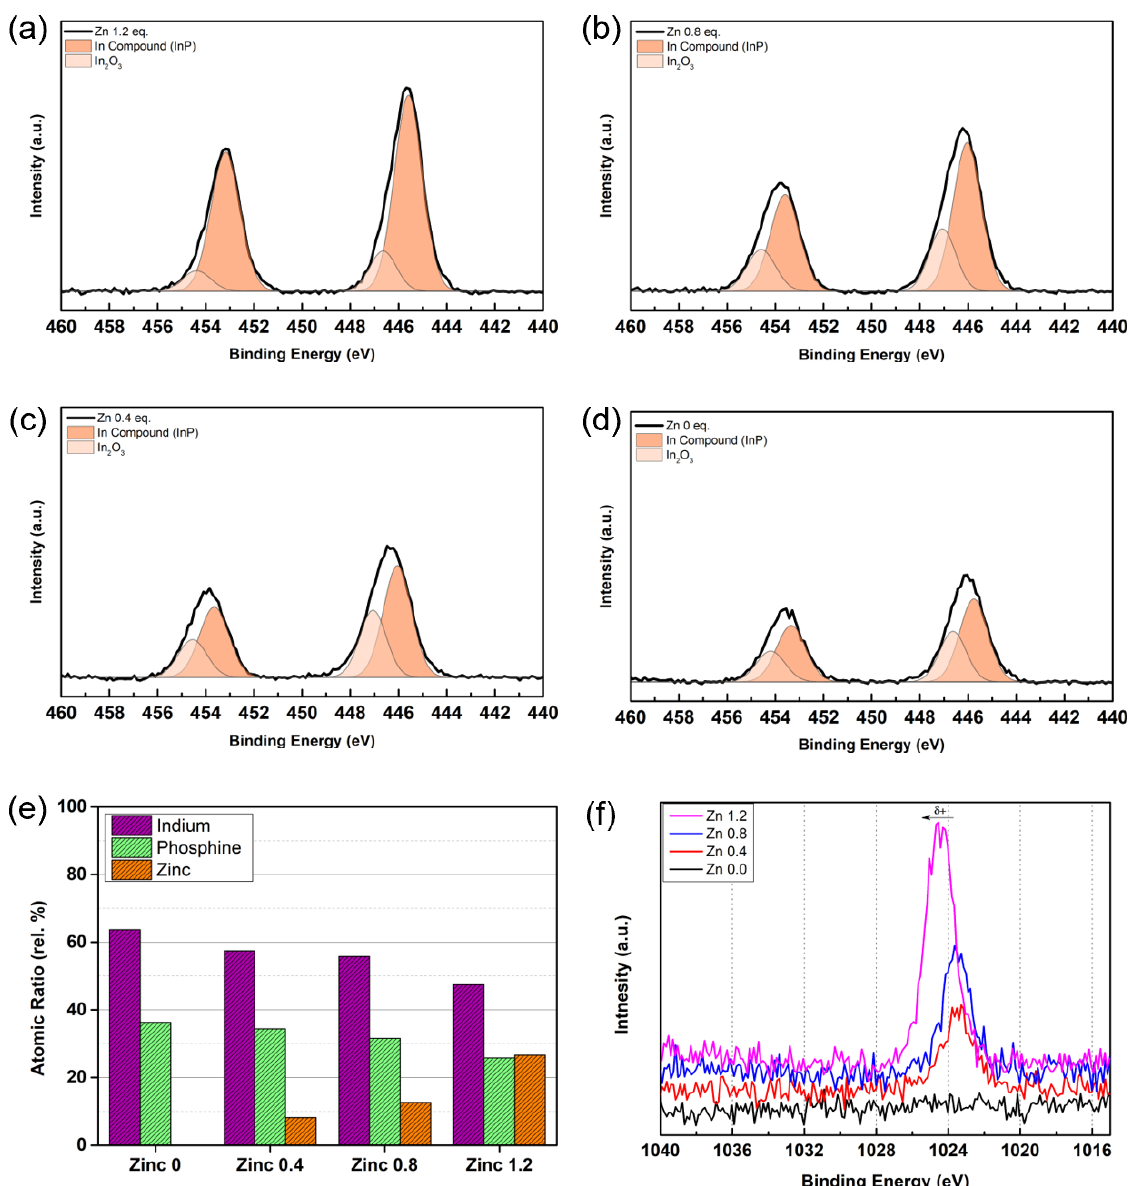
Figure 3. ( a – d ) XPS analysis of synthesized samples depending on the Zn loading amounts. ( e ) Quantitative analysis result of the synthesized samples. ( f ) Offset XPS spectrum of Zn 2p.